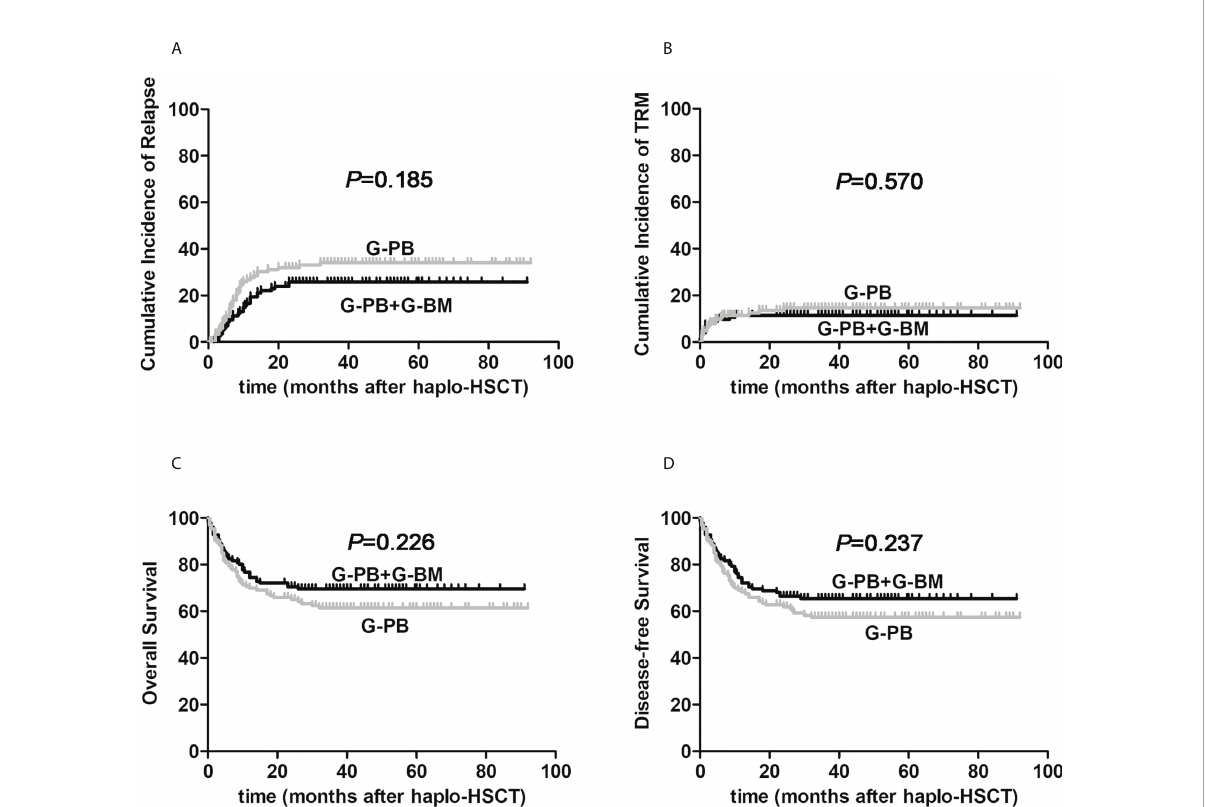
FIGURE 1 The in fl uences of graft constituents on post-transplant outcomes of patients with hematological malignancies undergoing ATG-based haplo- HSCT. The black line represents patients the combination of G-CSF-primed BM and PBSCs (n=125), the gray line represents patients the combination of G-CSF-primed PBSCs (n=126). (A) relapse; (B) TRM; (C) Overall survival; (D) Disease-free